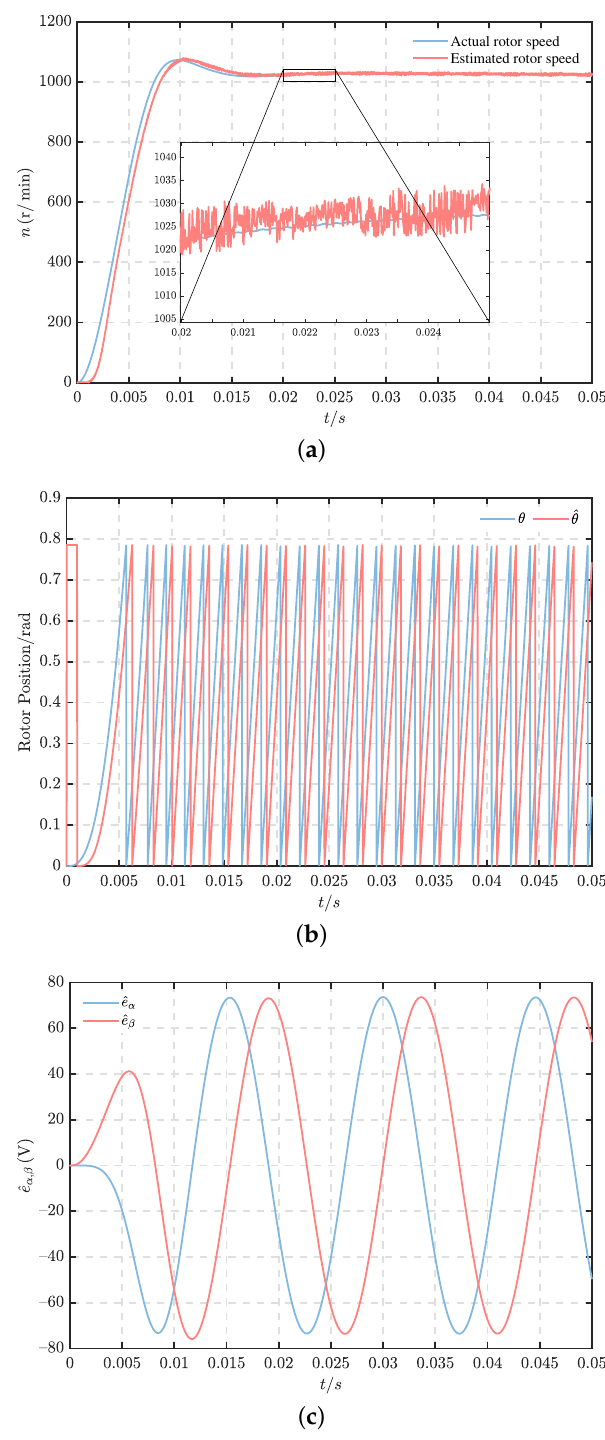
Figure 10. Responses of the simulation with conventional SMO combined with conventional PLL (steady-state). ( a ) Rotor speed. ( b ) Rotor position. ( c ) Estimation of the